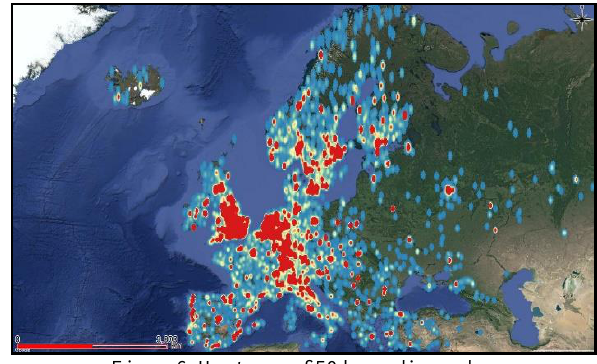
Figure 6. Heat map of 50 km radius